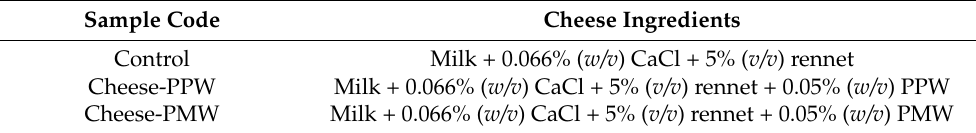
Table 1. Formulations of cheese samples under